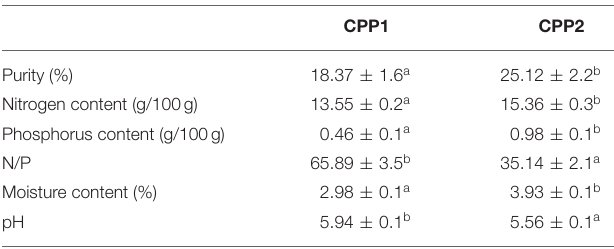
TABLE 1 | Composition of two commercially available casein phosphopeptides (CPP).